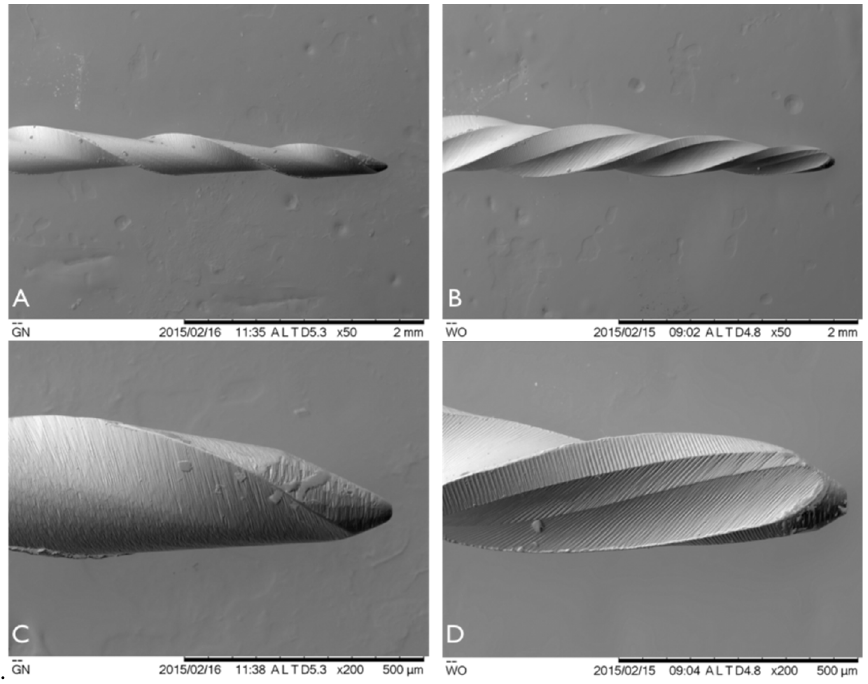
Figure 4. Micrographs of new GN instruments ( A , C ) and WO instruments ( B , D ) at × 50 and × 200 magnification. The differences in files surface structure are noticeable at both magnifications.